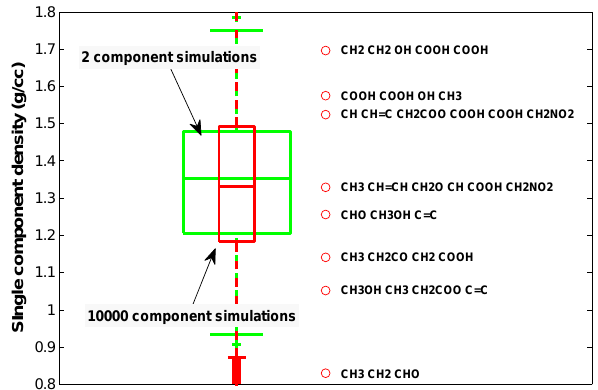
Fig. A1. Boxplots showing the range of individual compound den- sities used in the simulations described by McFiggans et al. (2010). The Green boxplot shows the range for 2 compound simulations, the red 10000 compound simulations. The open red circles show examples of the calculated densities of individual compounds con- structed using UNIFAC subgroups within the simulations described by McFiggans et al.